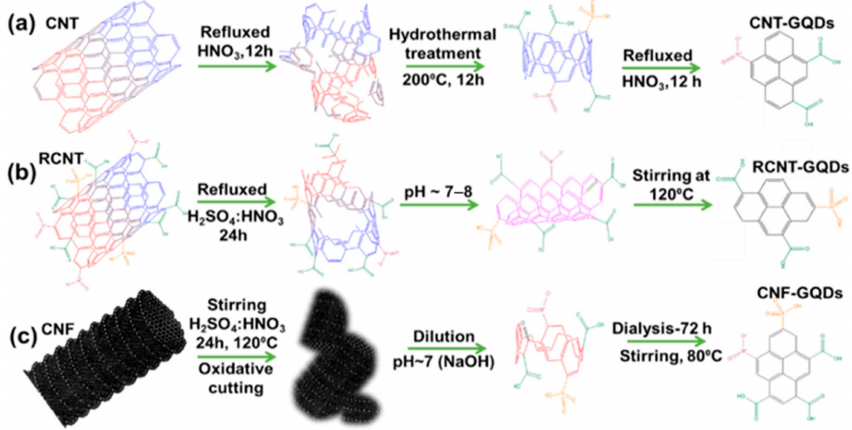
Figure 7. Schematic for the synthesis of N, S co-doped GQDs named as ( a ) CNT-GQDs, ( b ) RCNT- GQDs, ( c )